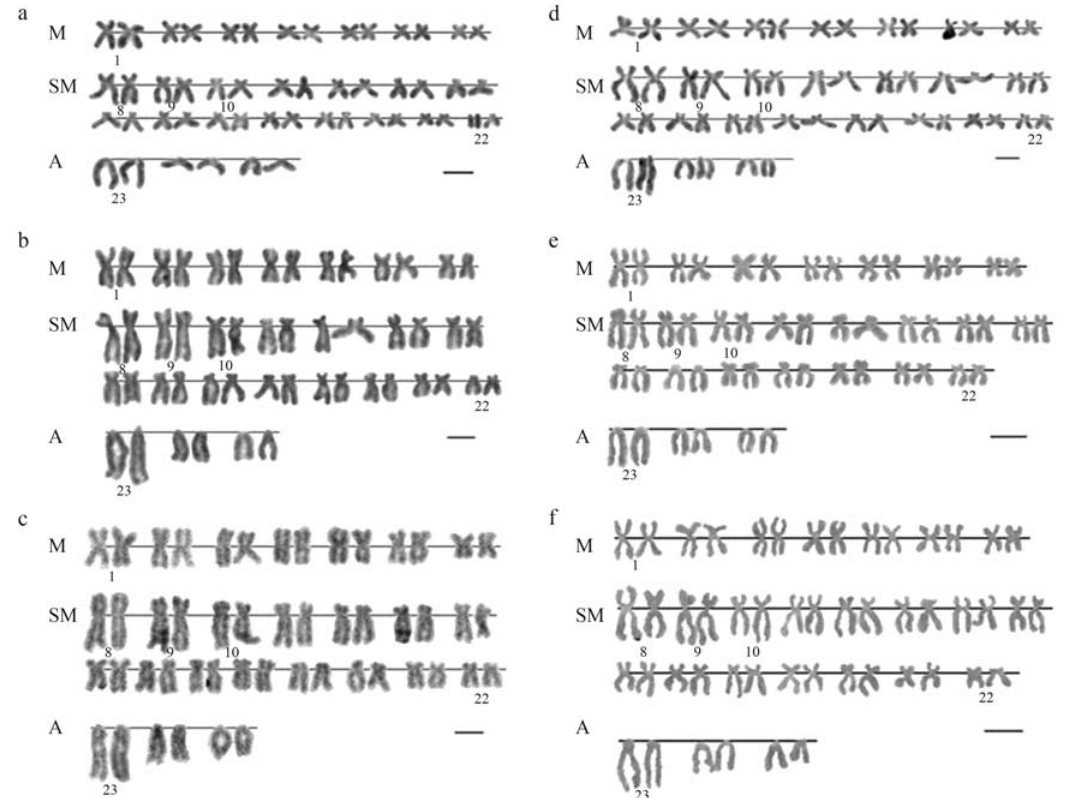
Figure 2 - Karyotypes of specimens of Iberochondrostoma lusitanicum ( a-d ) and I. almacai ( e-f ) after RE-banding (1000x): a ) Samarra - Hae III (fe- male); b )Tejo2- Alu I(female); c )Tejo1- Alu I(female); d )Junqueira- Hae III(male); e )Odelouca Alu I(juvenile); f )Odelouca Hinf III(juvenile).Thebar corresponds to 5 (cid:2)